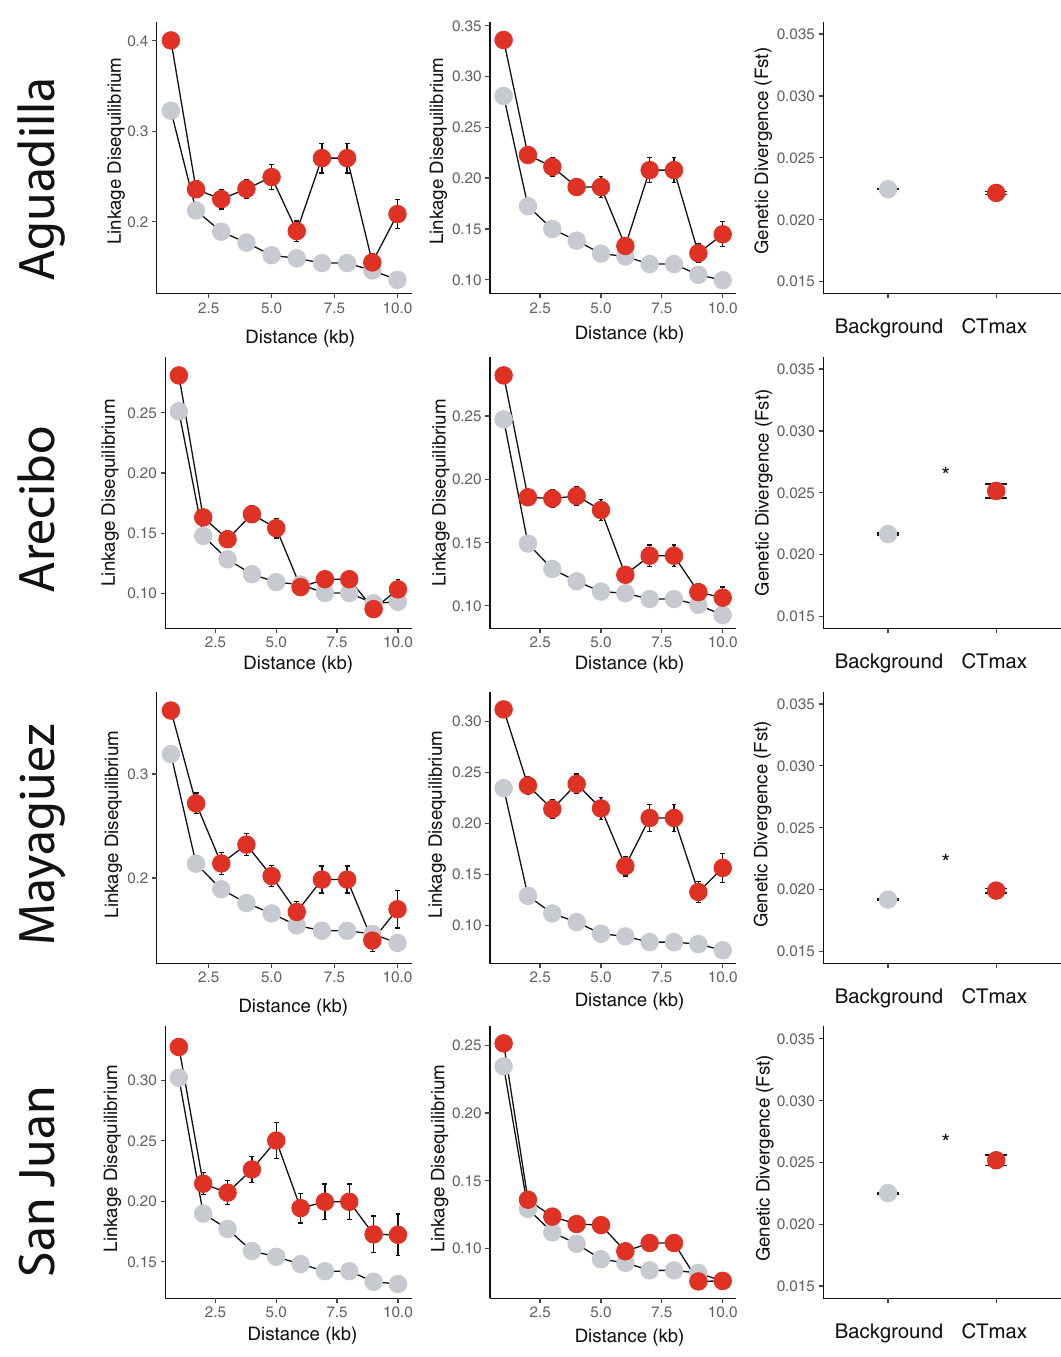
Fig. 4 Signatures of polygenic selection on CT MAX -associated SNPs. Extended linkage disequilibrium ( ≥ 5 kb) is observed in CT MAX -associated SNPs (red) in comparison to the transcriptome-wide background (gray) (linear mixed-effects model : p < 0.05) in both forest (Column 1) and urban (Column 2) habitats, suggesting ongoing selection on thermal physiology island-wide. In addition, increased genetic divergence between urban and forest habitats (Column 3) in CT MAX -associated SNPs (red) with respect to background (gray) expectations (Arecibo, Mayagüez, and San Juan: Welch t -test; p < 0.05 (asterisks)) supports selection on heat tolerance speci fi c to urban heat islands. LD plots are represented in 1 kb distance bins. Dots and error bars represent means± 1 SE. All 130 animals for which we had sequence data were used for this analysis. power within each regulatory category. However, the correlation between the wild-caught and common garden data sets remained signi fi cant in each case (positive regulators: R 2 : 0.04, p < 0.0002; negative regulators R 2 : 0.03, p = 0.0003). In summation, our candidate gene set displays similar expression-phenotype correlations and relative rank correlations between common garden and wild-caught individuals, supporting the gene set as 6 NATURE COMMUNICATIONS| (2021) 12:6195